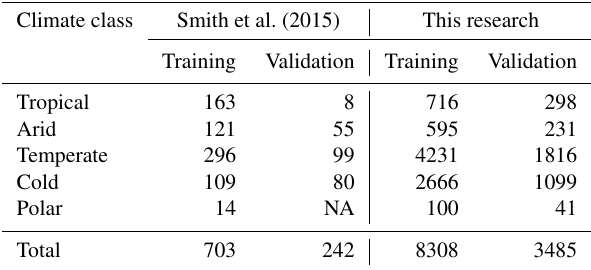
Table 1. The number of discharge stations for model development in each climate class. NA stands for “not